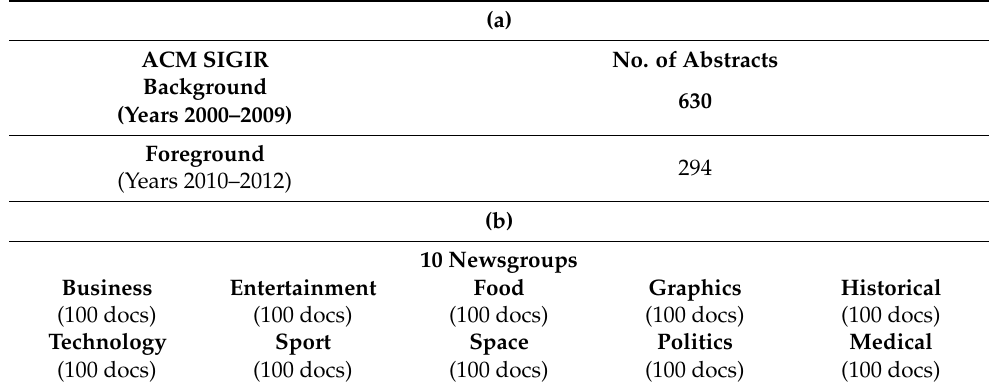
Table 1. (a) SIGIR and (b) 10 Newsgroups datasets.